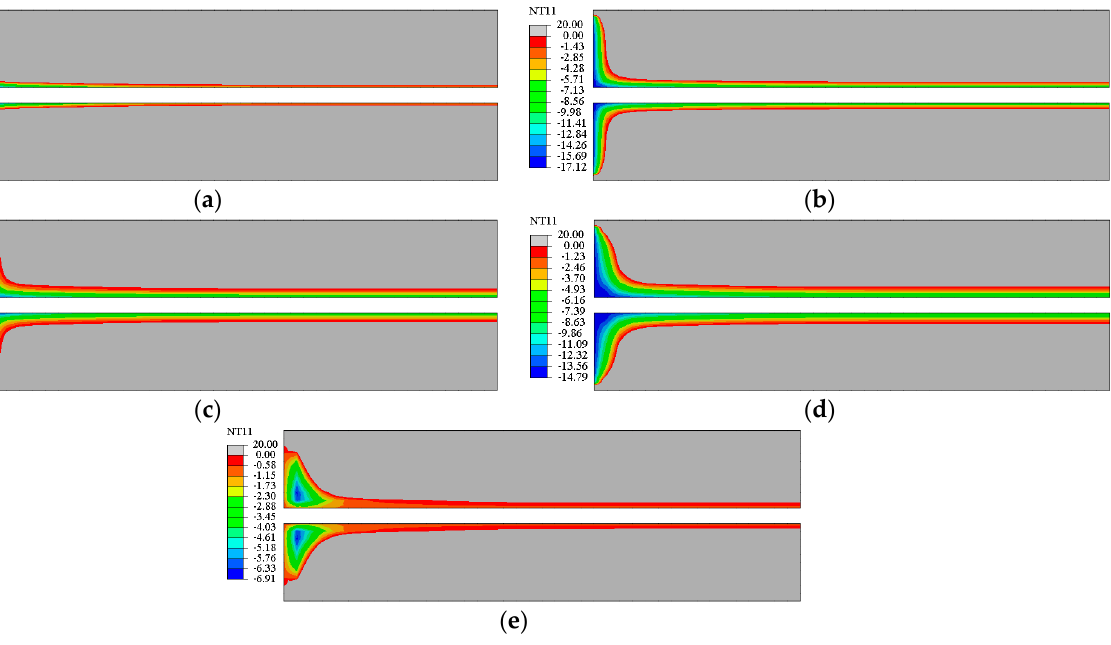
Figure 7. Vertical temperature cloud map. ( a ) 60 d after freezing. ( b ) 95 d after freezing. ( c ) 130 d after freezing. ( d ) 165 d after freezing. ( e ) 200 d after freezing.